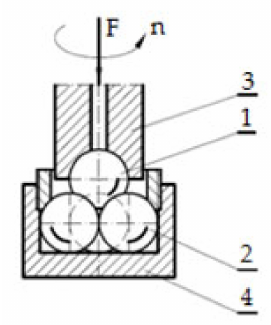
Figure 2. Scheme of the four-ball apparatus. 1 = the top ball, 2 = the bottom balls and 3 and 4 = the holders.